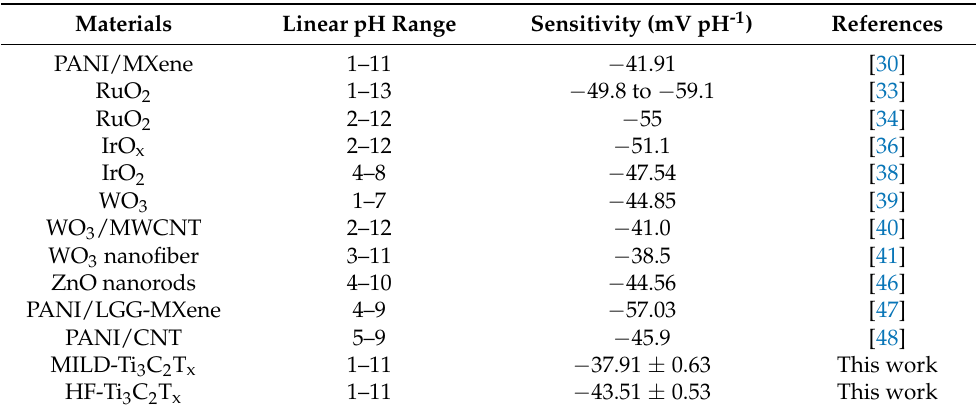
Table 1. The comparison of analytical performances between this work and other reported potentio- metric pH